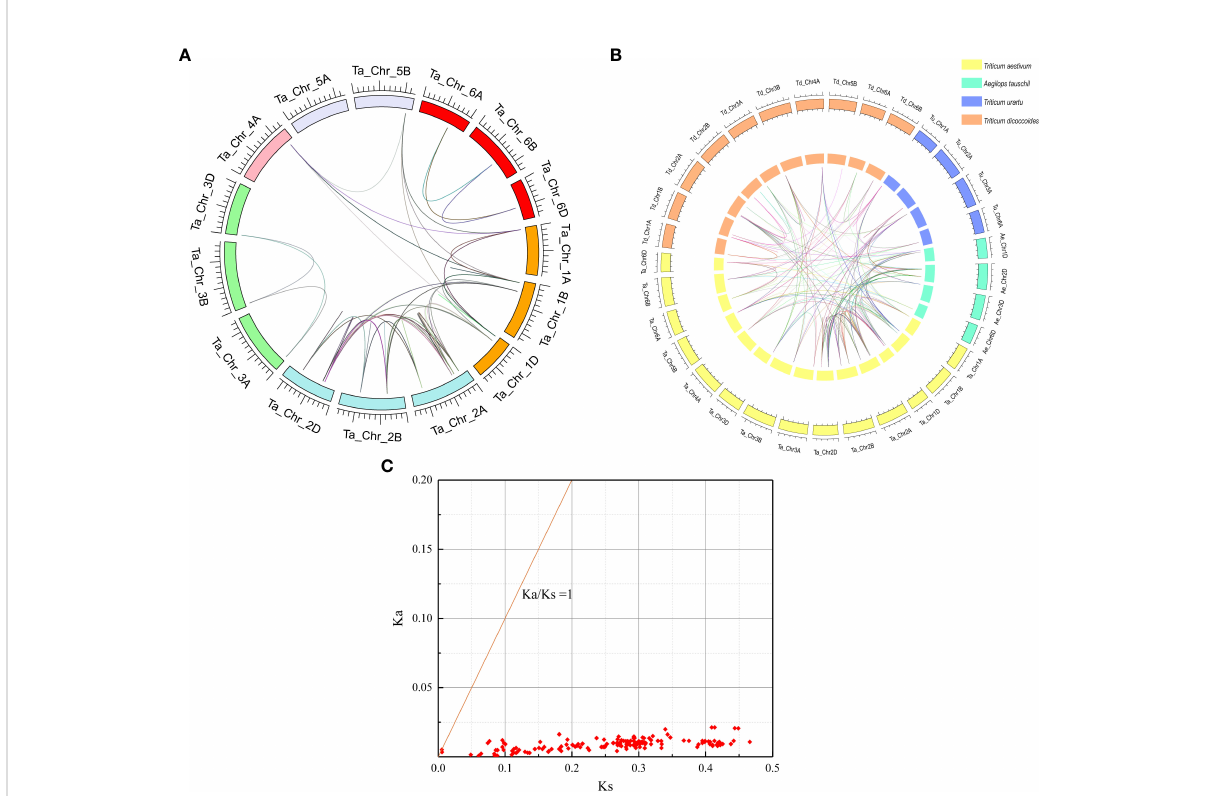
FIGURE 4 Whole genome duplication (WGD)-derived and homology relationship analysis of wheat PAL genes. (A) Analysis of genome-wide PAL genes replication events in common wheat (Ta, AABBDD). Different colors represent different chromosomes; WGD/segmentally duplicated TaPAL gene pairs are linked by different colored lines. (B) Homology relationship analysis of the TaPAL genes of Triticum aestivum and its subgenome donors Triticum urartu , Triticum dicoccoides , and Aegilops tauschii . The reference genomes of T. urartu (v. 1.43), T. dicoccoides (v. 1.0.43), and A . tauschii (v. 4.0.43) were downloaded from the Ensembl Plants database (http://plants.ensembl.org/index.html). The orange box represents T. dicoccoides , the blue box represents T. urartu , the cyan box represents A. tauschii and the yellow box represents T. aestivum . (C) Ka/Ks values for duplicated TaPAL genes